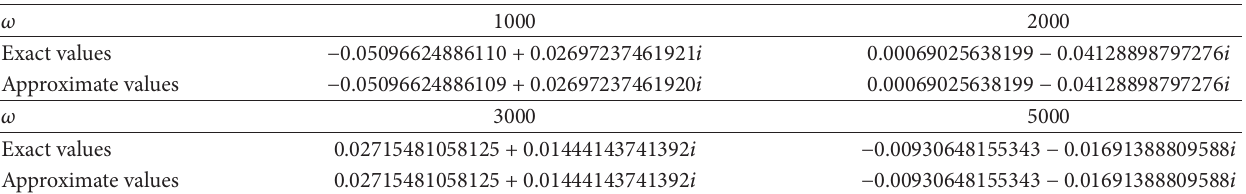
Table 4: Approximate values in 2 -point approximations by the proposed method to the integral ∫ compared with exact values.